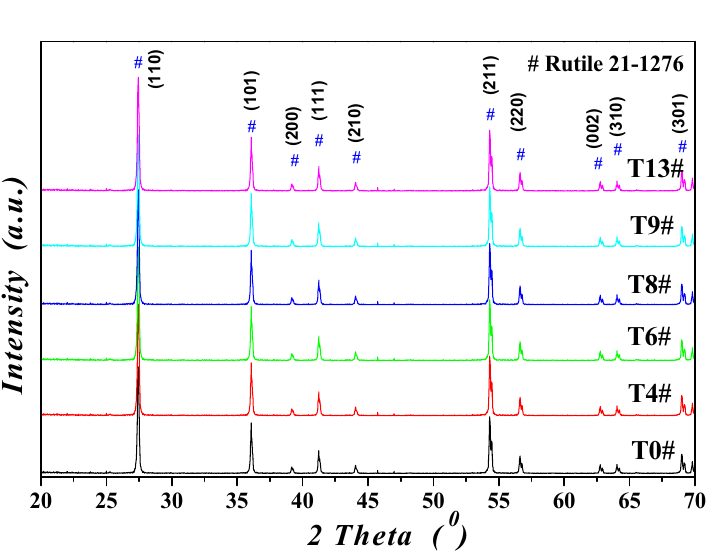
Figure 6. XRD patterns for the high purity TiO 2 samples.